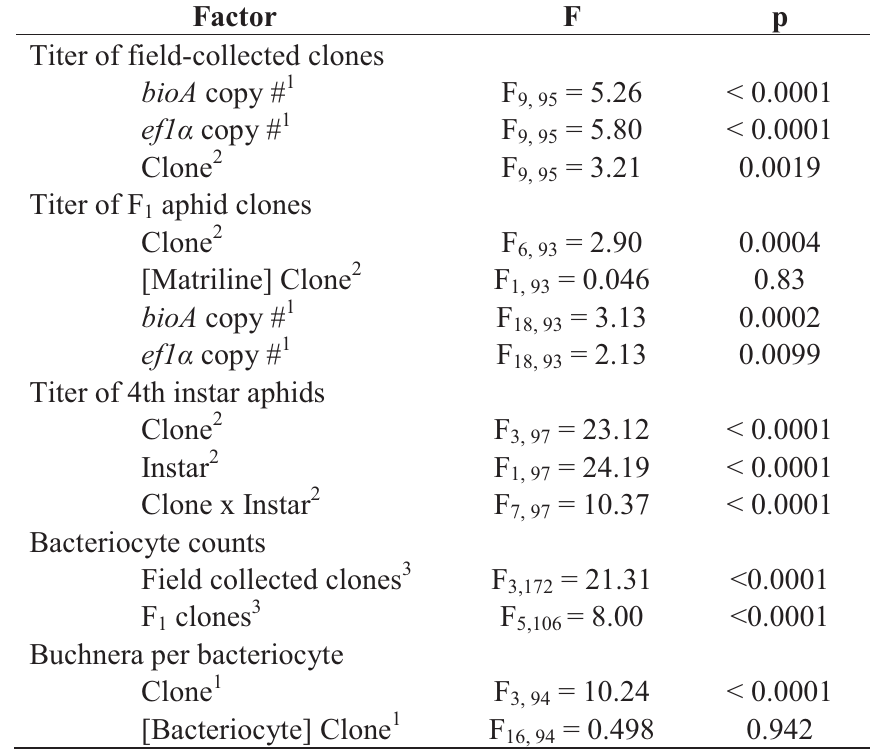
Table S2. Summary statistics of